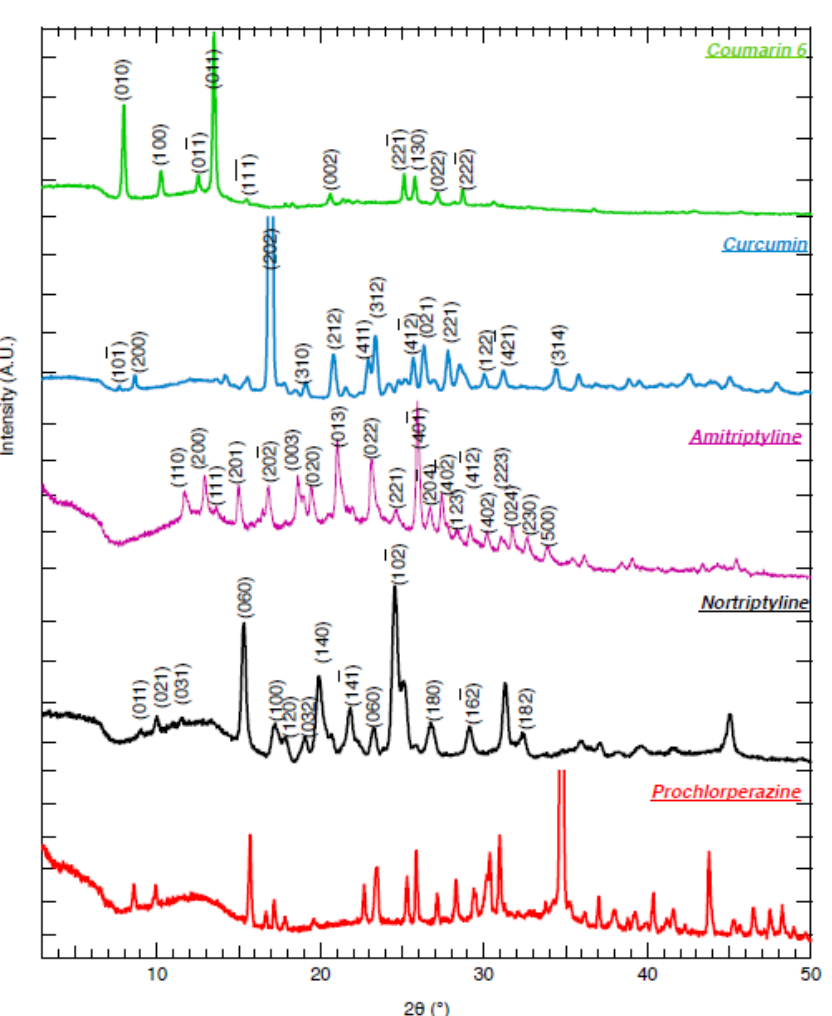
Figure 4. XRD data of freeze-dried samples of COU, CUR, AMI, NOR, and PRO particles. The XRD intensities are presented in logarithmic scales. The Miller indices of the main peaks are indicated for COU, CUR, AMI and NOR.